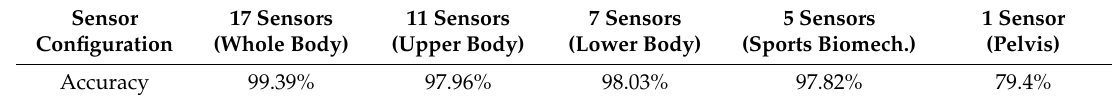
Table 8. Training dataset accuracies for the five different sensor configurations.